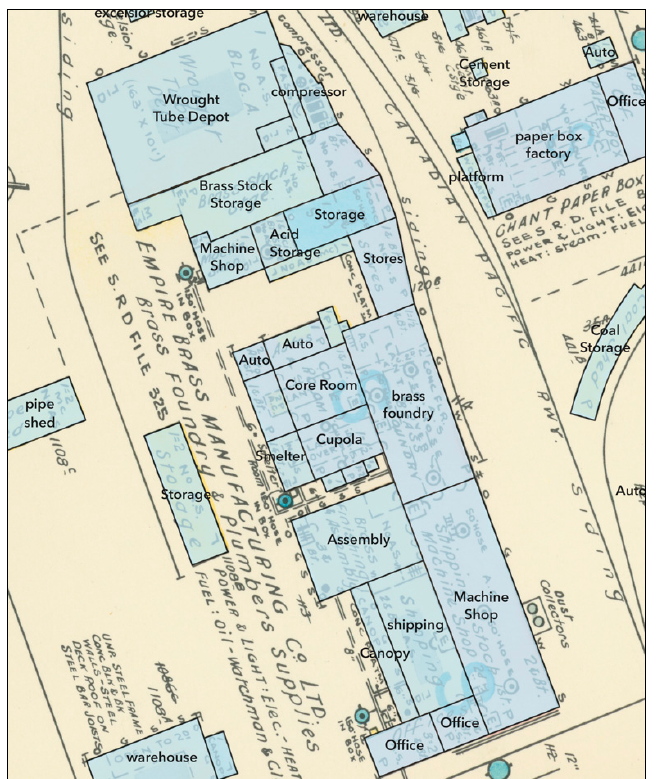
Figure 3. Industrial activity within the London HDSI is recorded at the sub-building footprint resolution, identifying discrete historical activity areas within a building or building complex. Image by author.